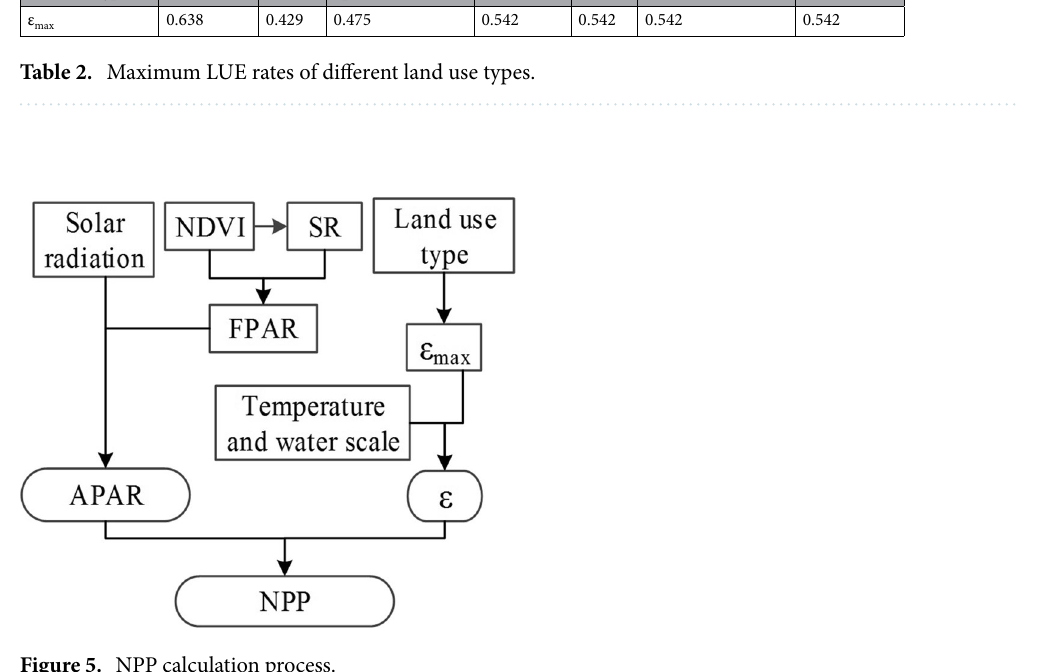
Figure 5. NPP calculation